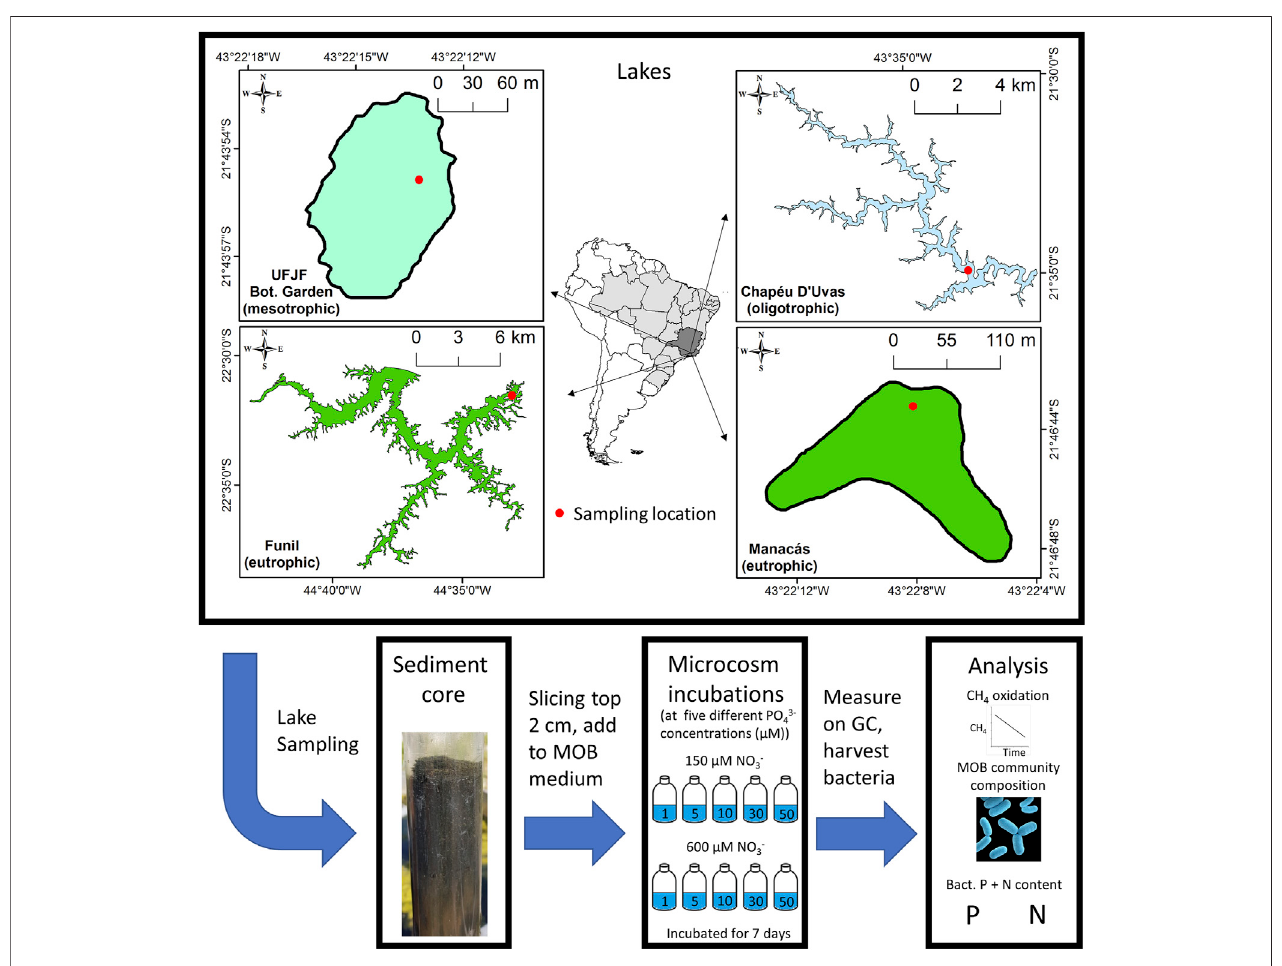
FIGURE 1 | Sampling sites and experimental